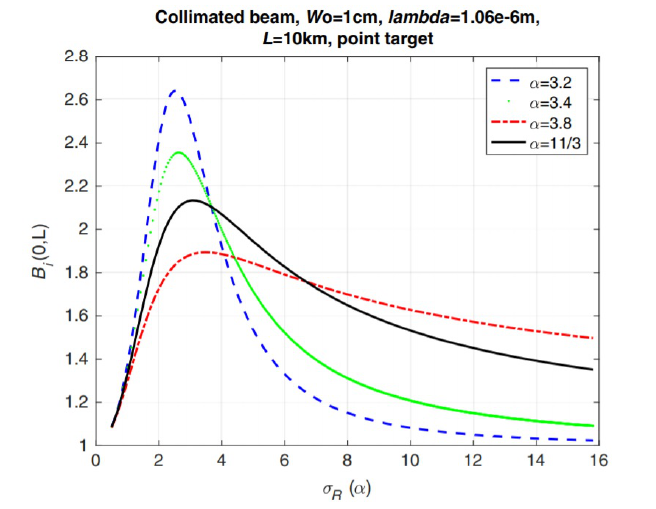
Figure 23. Mono-static case: enhancement factor as a function of the square root of the Rytov variance for several power law values. Reprinted with permission from Reference